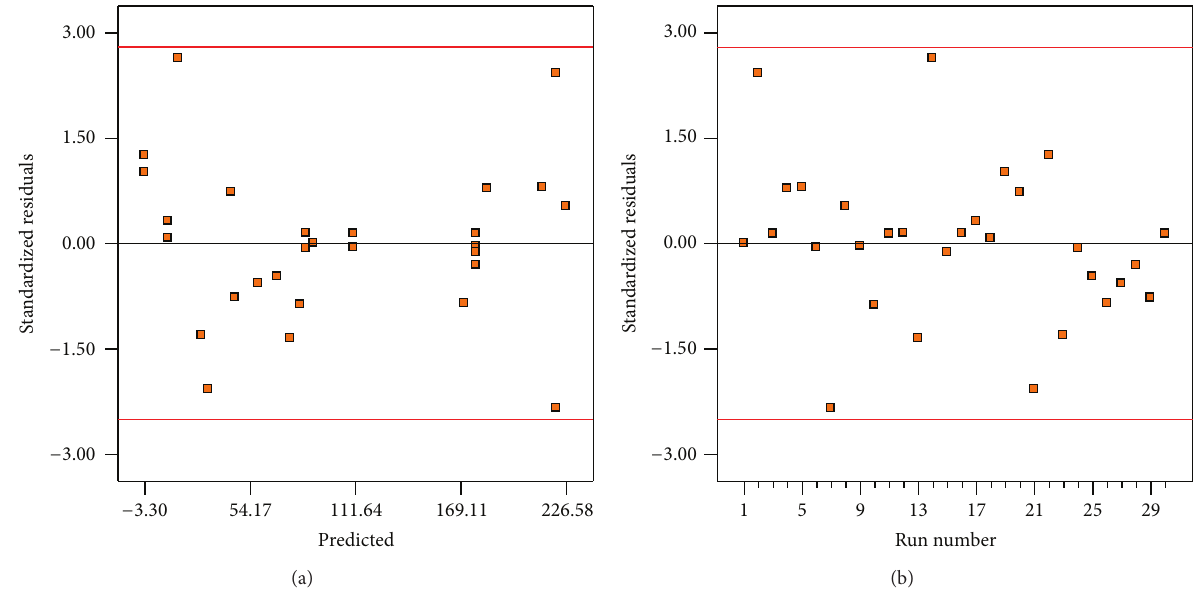
Figure 4: Diagnostic plots for bioethanol yield (a) residual versus predicted yield and (b) residual versus run number.